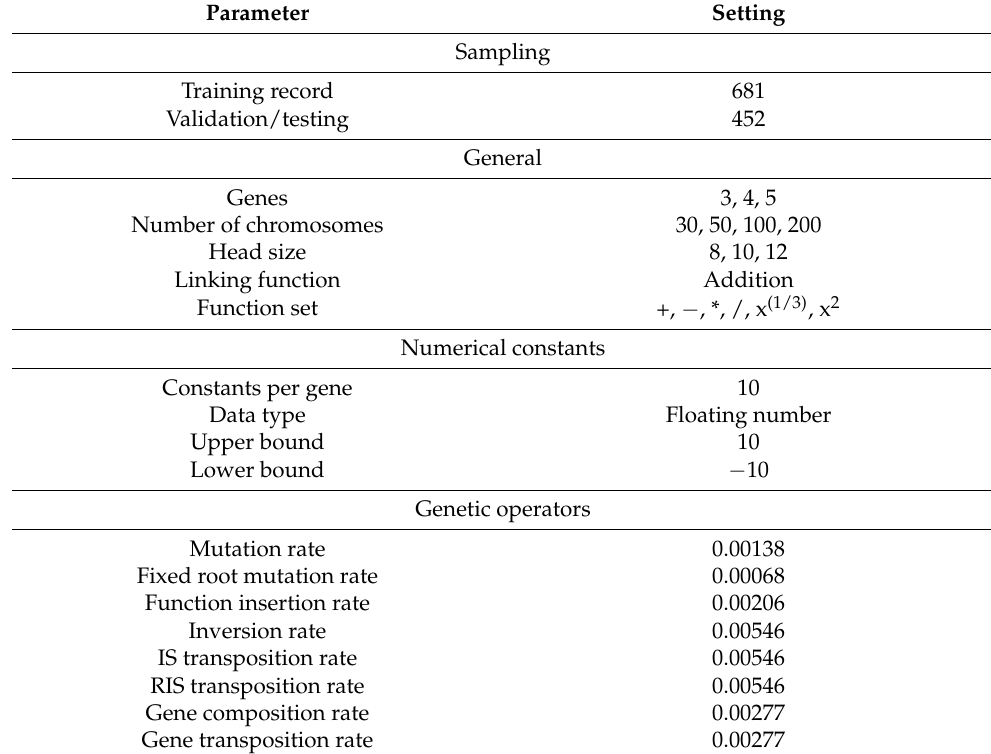
Table 4. Setting parameters for the GEP models.